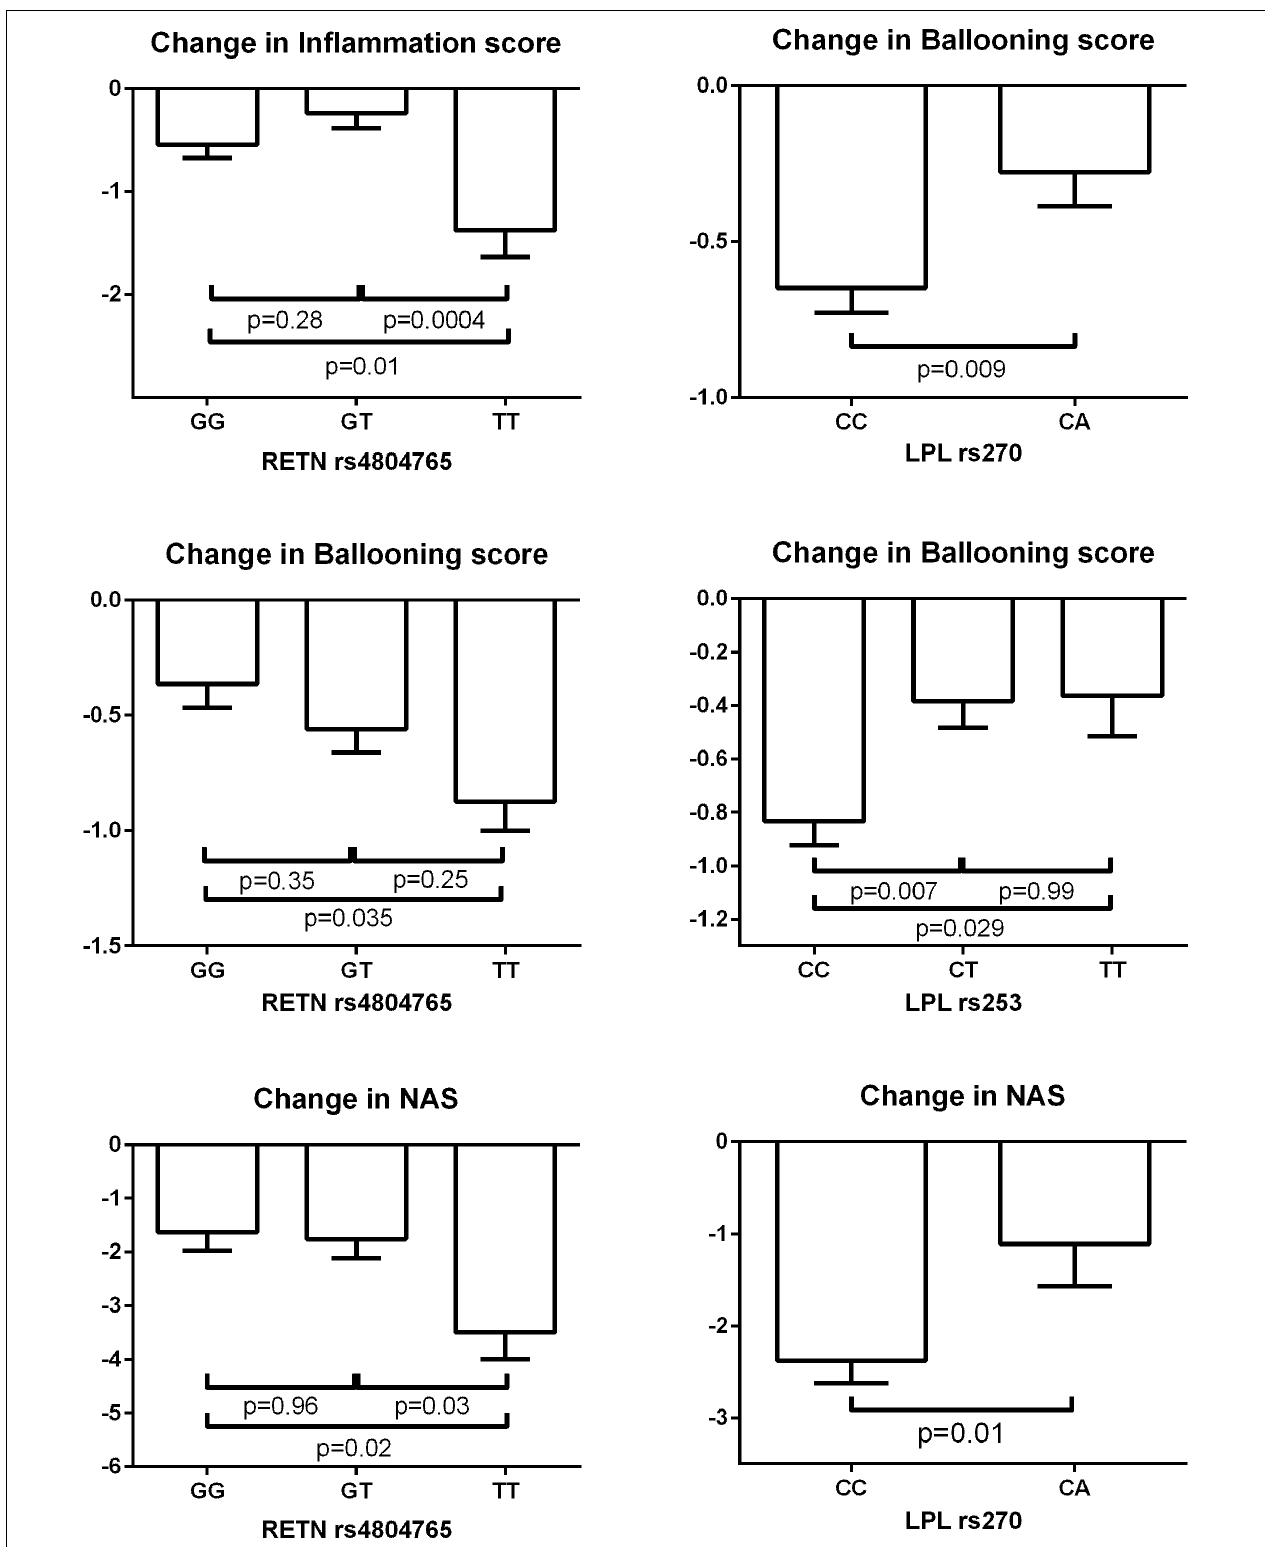
FIGURE 3 | Change in biopsy scores based on genotypes of SNPs identified by meta-analyses. The bar columns and error bars represent the means and the standard errors of the means respectively. The shown p -values are adjusted for multiple comparisons by Tukey’s method.